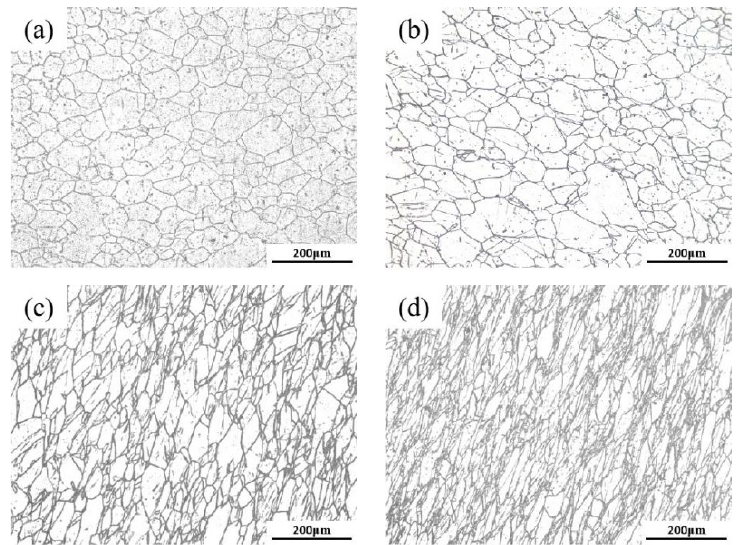
Figure 7. The metallographic photographs of C250 after deformation: ( a ) 15%; ( b ) 30%; ( c ) 45%; ( d ) 60%. Table 1. The size of grain and martensite lath of C250 after deformation and heat treatment.